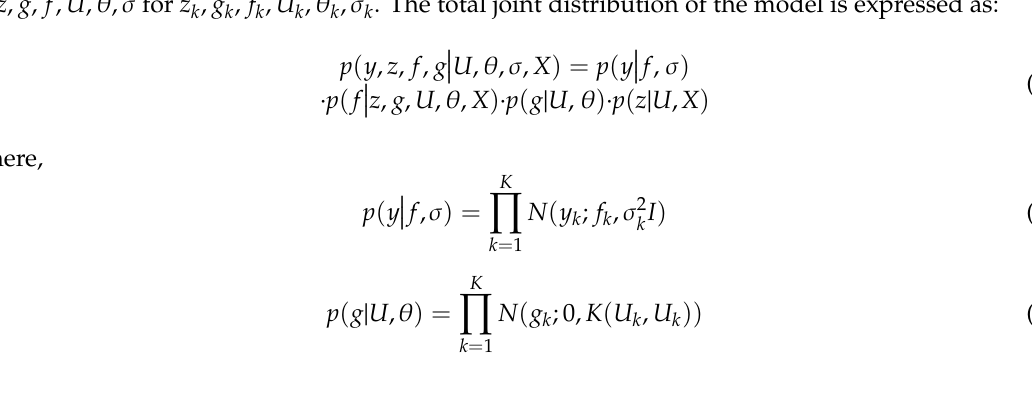
Figure 5. Mixture Gaussian process regression (MGPR) model representation.